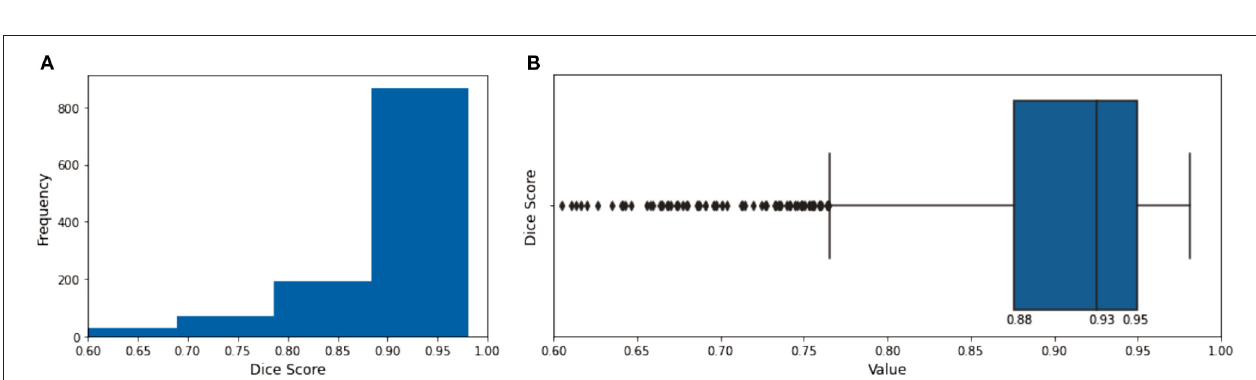
FIGURE 4 | The histogram (A) and the boxplot (B) of the dice score of the evaluation dataset. The 25, 50, and 75% percentiles are 0.88, 0.93, and 0.95, respectively.